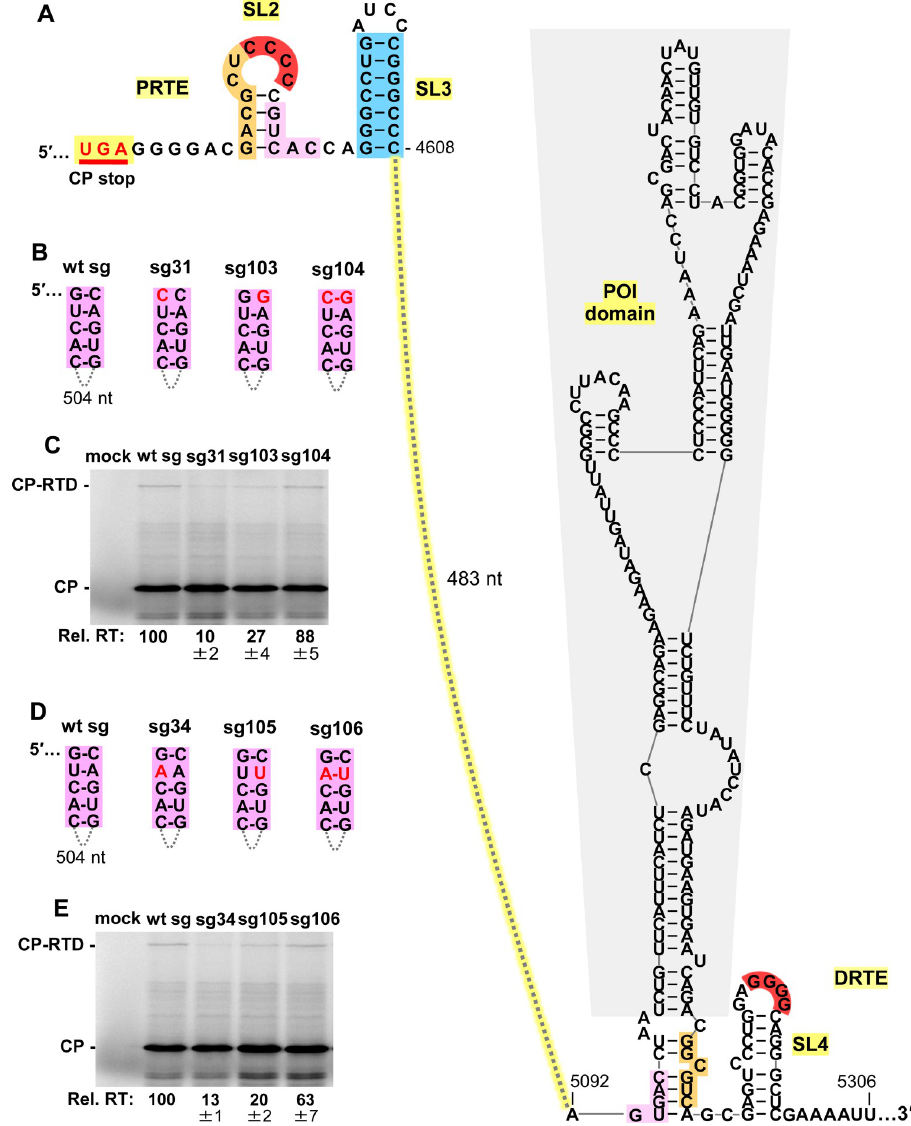
Fig 6. Assessing the pink long-distance RNA-RNA interaction. (A) RNA secondary structures of PRTE and DRTE in PEMV1, including the POI domain (grey shading). The complementary sequences highlighted in pink represent a third long-distance RNA-RNA interaction between PRTE and DRTE. (B) and (D) Compensatory mutations introduced in the sg mRNA context to test the pink interaction. Nucleotide substitutions are shown in red. (C) and (E) In vitro translation analyses of the wt and mutant sg mRNAs shown in panels B and D, respectively. Averaged Rel. RT levels ( ± SE) collected from three independent trials are shown below each